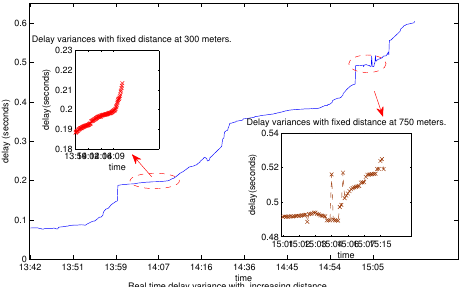
Figure 1. The acquisition of the two scale